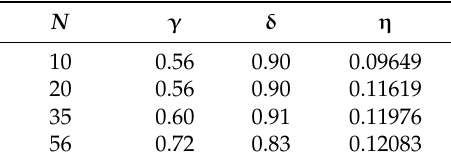
Table 1. Convergence of phase shifts η (radians) for e + -H scattering with respect to the number of correlation terms N for k = 0.4.